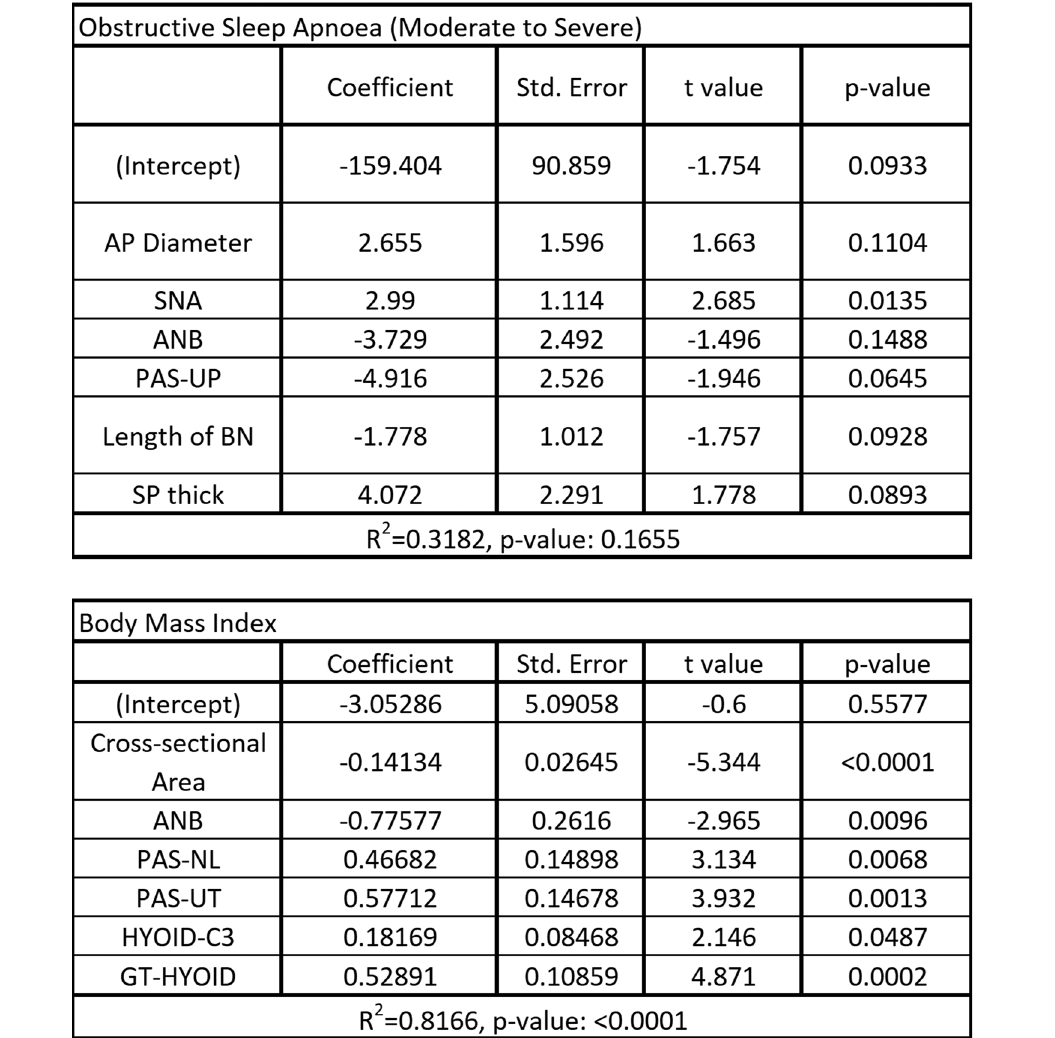
Table III. Predicting key variables using multiple regression